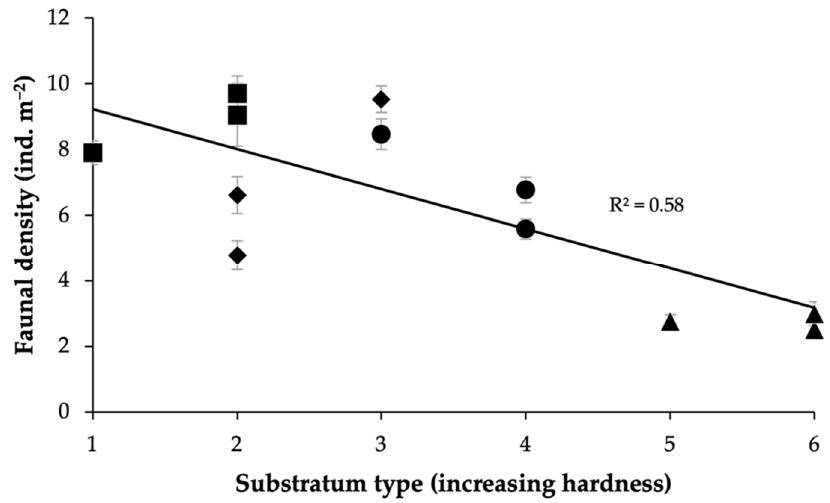
Figure 4. Megafaunal density generally decreases with increasing hardness of the substratum. Mean faunal densities (ind. m − 2 ) ( ± SE) of samples with substratum type (scale of increasing hardness from left to right), where 1 = soft-sediment: mixed; 2 = mixed: soft-sediment; 3 = mixed: boulder; 4 = assorted hard: mixed; 5 = assorted hard: boulder/mixed; and 6 = assorted hard: boulder. Site LCP1 = diamonds, LCP2 = triangles, LCP3 = circles, and LCP4 = squares.